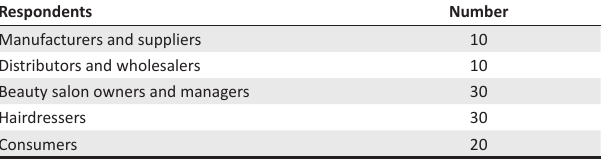
TABLE 1: Sample size of the quantitative approach. Respondents